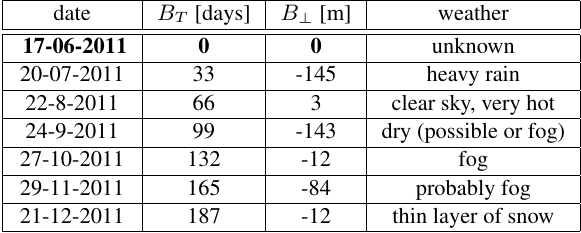
Table 1: Data used, together with temporal and perpendicular baselines. The data were acquired by the TerraSAR-X satellite in the StripMap mode (with incidence angle 29–32 degrees. Mas- ter scene is in bold and the temporal and perpendicular baselines refer to it.